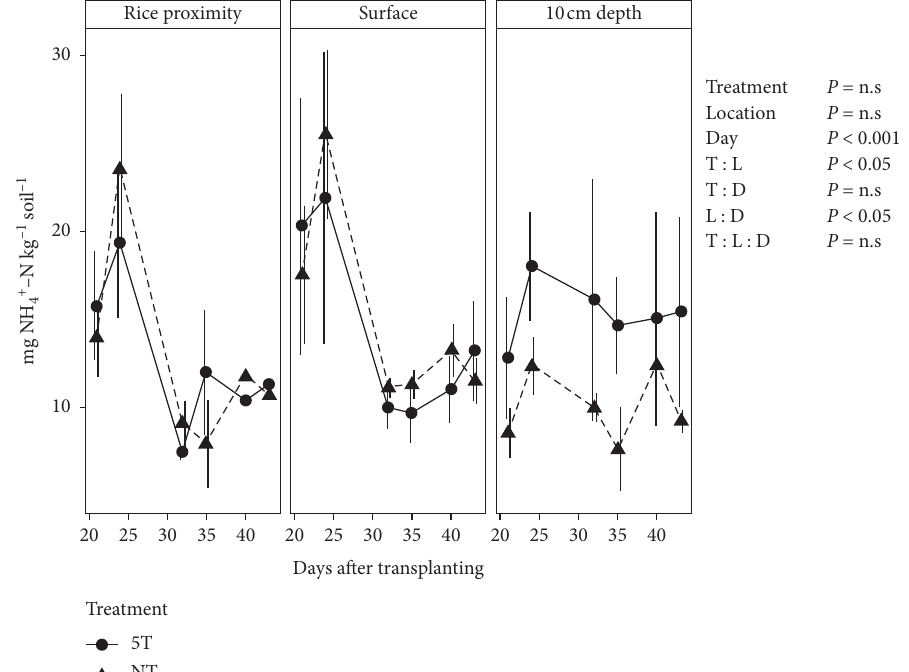
Figure 6: Fluctuation of ammonium (NH + –N) after transplanting at location of rice proximity, surface, and 10cm depth under no tillage 4 (NT) and 5 times tillage (5T) treatment. Level of significance was determined by three-way ANOVA. Error bars represent standard deviations ( n �